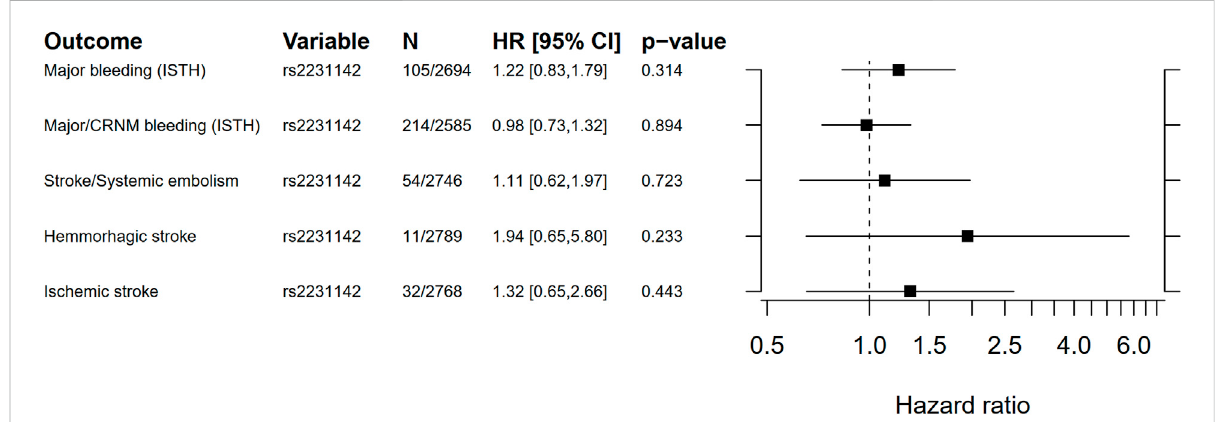
FIGURE 4 Forest plot for the Cox proportional hazard ratio for carrying rs2231142 versus bleeding and thromboembolic events. Ninety fi ve percent con fi denceintervals(CI)forincidencerateswereestimatedusingagammadistribution.ISTH,InternationalSocietyonThrombosisandHaemostasis; CRNM, clinically relevant non-major